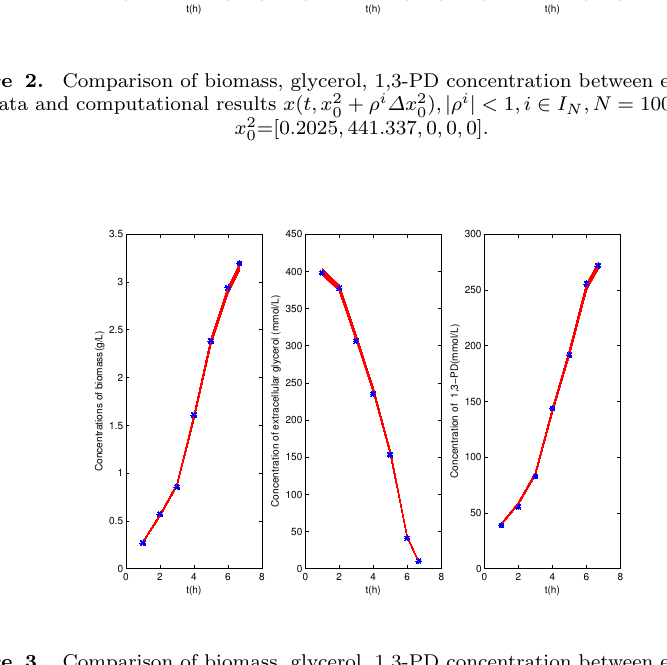
+ ρ i ∆x 3 ) , | ρ i | < 1 ,i ∈ I N ,N = 1000 , with 0 0 x 3 =[0 . 173 , 402 . 9348 , 0 , 0 , 0